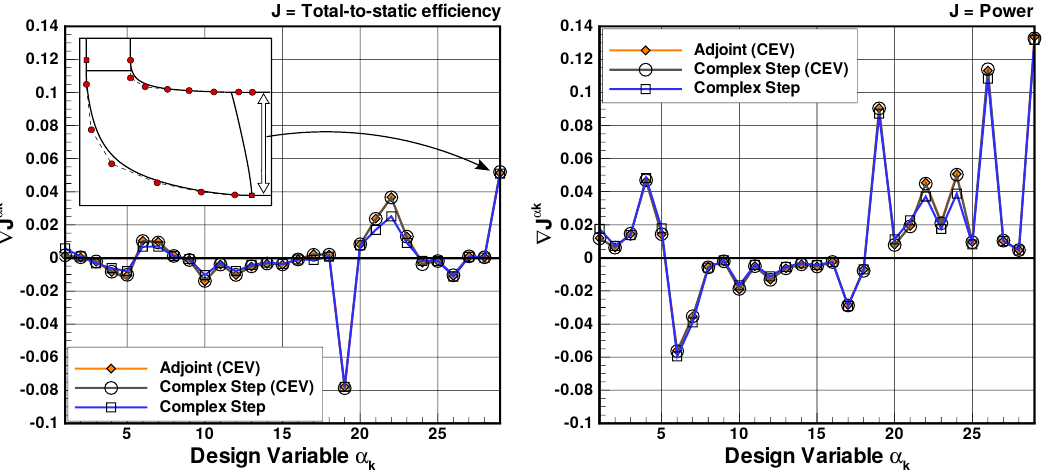
Figure 9. Comparison of non-dimensional design gradients of total-to-static efficiency ( left ) and power ( right ) computed with the adjoint method and complex-step method. CEV: Constant Eddy